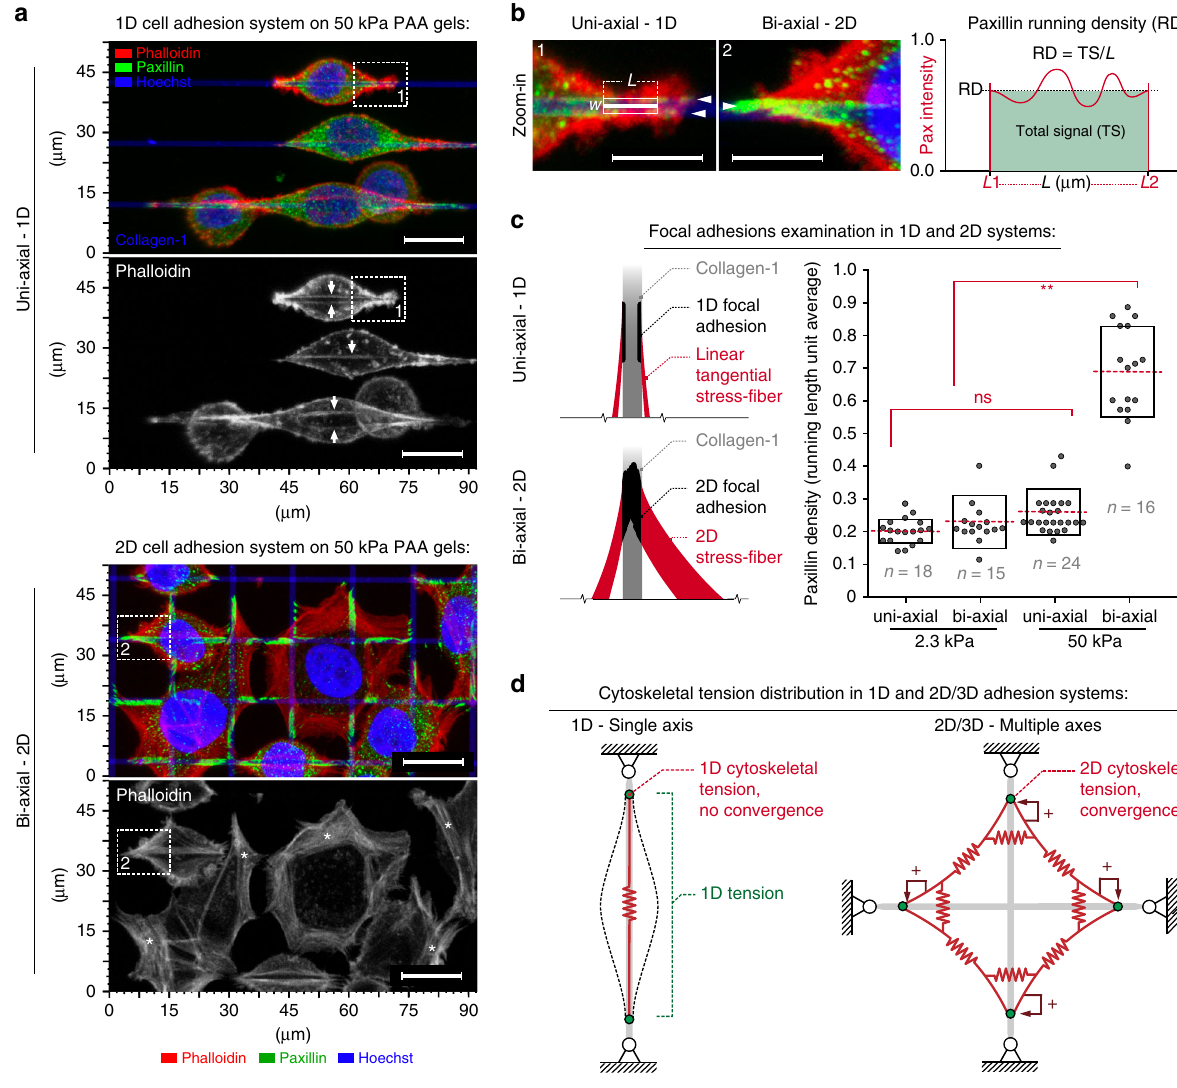
Fig. 3 Cell adhesion and mechanical responses to distinct guidance cue dimensionality and rigidity. a Fluorescence 3D reconstruction micrographs of F- actin (phalloidin — red), FAs (paxillin — green), and nuclei (Hoechst — blue) on stiff uniaxial and biaxial platforms reveal a more robust development of the FA and stress- fi ber contractile apparatus in response to biaxial cues versus 1D cues. White arrows (top panel) highlight actin fi bers. Boxes 1 and 2 are zoomed-in regions shown in b . b Zoomed-in apical regions shown in a . Arrowheads highlight prominent FA development homogeneously fi lling the line in response to biaxial cues (2) while paxillin distribution for uniaxial cues is more localized at the line edges (1). To capture differences in FAs, we employ a metric of running length density. Paxillin running density is an “ intensive ” parameter that re fl ects the total paxillin signal per micron of length along collagen guidance cue axes to characterizes the build-up of FAs in terms of structural density, maturity, and level of integration with contractile stress- fi bers (see right panel). c Schematic representation of the observed FA and corresponding stress- fi ber architectures for cells encountering uniaxial or biaxial cues and quanti fi cation of FA running length densities for soft and stiff 1D and biaxial substrates (** p < 0.001). d Model of the cell mechanical response during sensing of uniaxial and biaxial cues. The uniaxial guidance cues result in highly anisotropic forces guided along adhesions and the actin fi ber cytoskeleton (CSK) that are co-aligned with the uniaxial cues such that linear tension ( λ ) is distributed along the CSK structure. In contrast, biaxial cues provide opposing forces across a wide range of angles and adhesion sites resulting in robust mechanical feedback loops that promote traction stresses, FA maturation, and stress- fi ber formation, inducing robust linear tension along arcs and formation of associated stress- fi bers (bottom panels of a ) that converge to generate higher stress magnitudes at FAs. Scale bars — 15 µ m. Corresponding n values are shown on the plot. Number of replicates (independent experiments) for all measurements N = 2. Data in c are mean ± s.d (boxes); ns indicates no signi fi cant difference between groups; * p < 0.05, ** p < 0.001